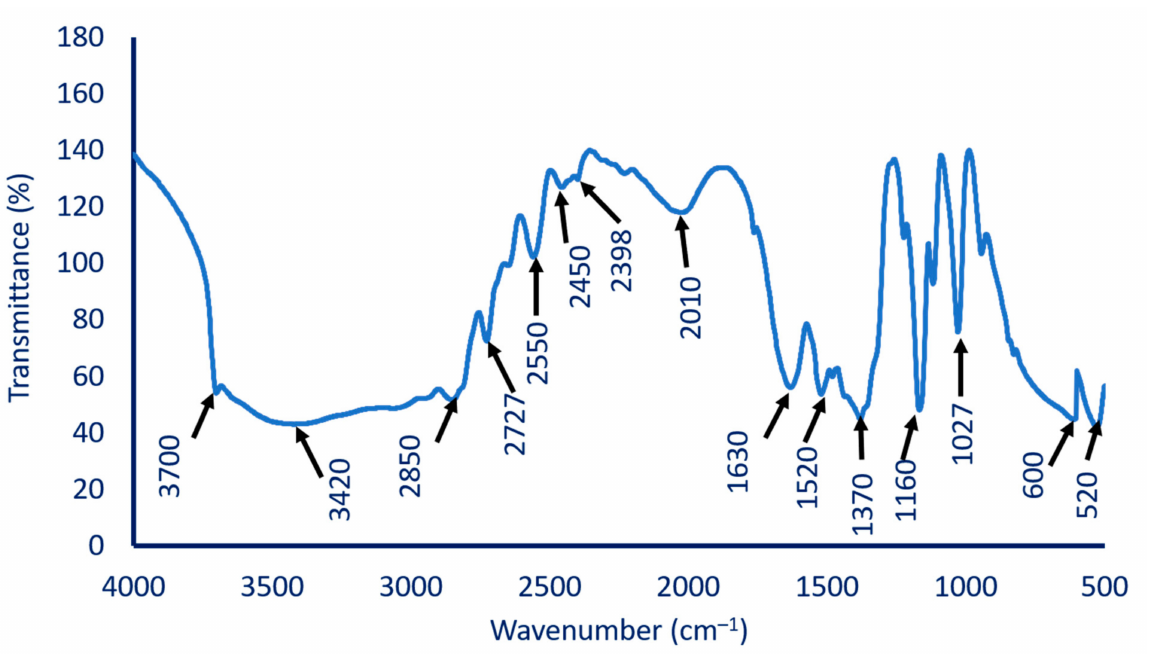
Figure 4. The FT-IR spectrum of myco-synthesized MgO-NPs fabricated by metabolites of A. terreus strain